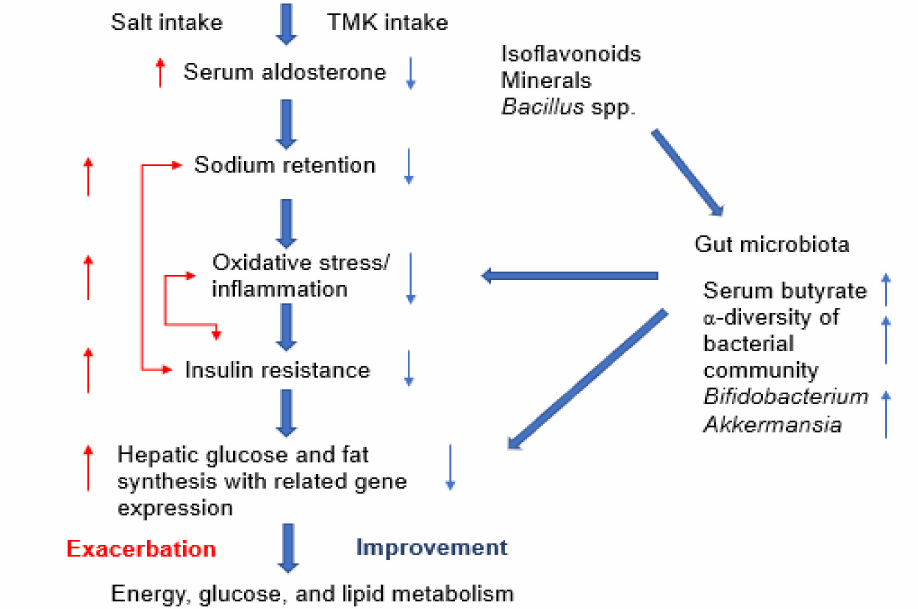
Figure 6. The potential mechanism of traditionally made kanjang (TMK) in the metabolic distur- bance in an estrogen-deficient animal model. Salt intake exacerbated metabolic disturbance in estrogen-deficient animals by increasing serum aldosterone concentrations to elevated oxidative stress, inflammation, and insulin resistance, and it disturbed hepatic glucose and fat metabolism. Instead of salt, TMK intake, containing isoflavonoids, minerals, and Bacillus spp., improved the distur- bance of energy, glucose, and lipid metabolism. TMK reduced serum aldosterone concentrations and increased serum butyrate concentrations by modulating the gut microbiota community, particularly elevating Bifidobacterium and Akkermansia. TMK reduced oxidative stress, inflammation, and insulin resistance, decreasing hepatic glucose and fat metabolism in estrogen-deficient animals. Red and blue arrows indicated the increase (exacerbation) and decrease (improvement) of each parameter, respectively. Red bidirectional arrows indicated the mutual interaction between the